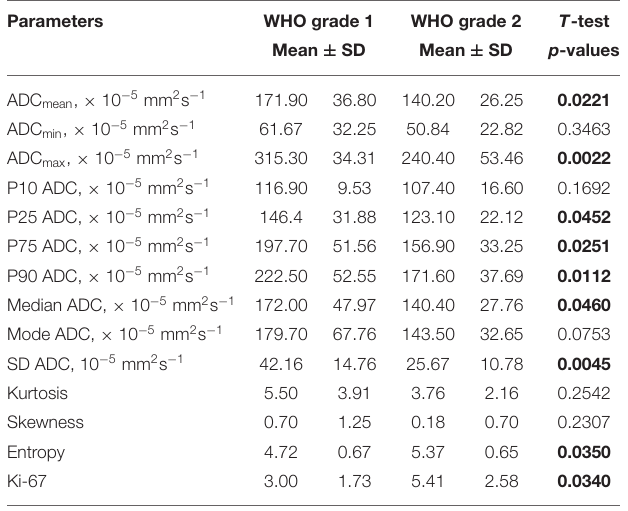
TABLE 2 | Comparison of DWI histogram profiles and Ki-67 index between grade I and grade II glioma. Parameters WHO grade 1 WHO grade 2